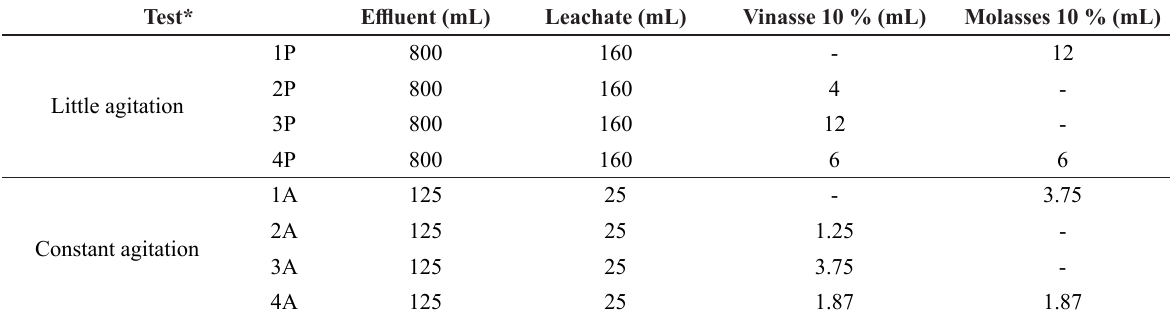
*We added molasses for the 1P/A tests, vinasse in smaller quantity for the 2P/A tests, vinasse in a larger amount for the 3P/A tests, and equal amounts of molasses and vinasse for the 4P/A tests. We obtained samples 1-4P in rectangular-based containers under manual and periodic agitation, while samples 1-4A were packed in a 250 mL Erlenmeyer under constant